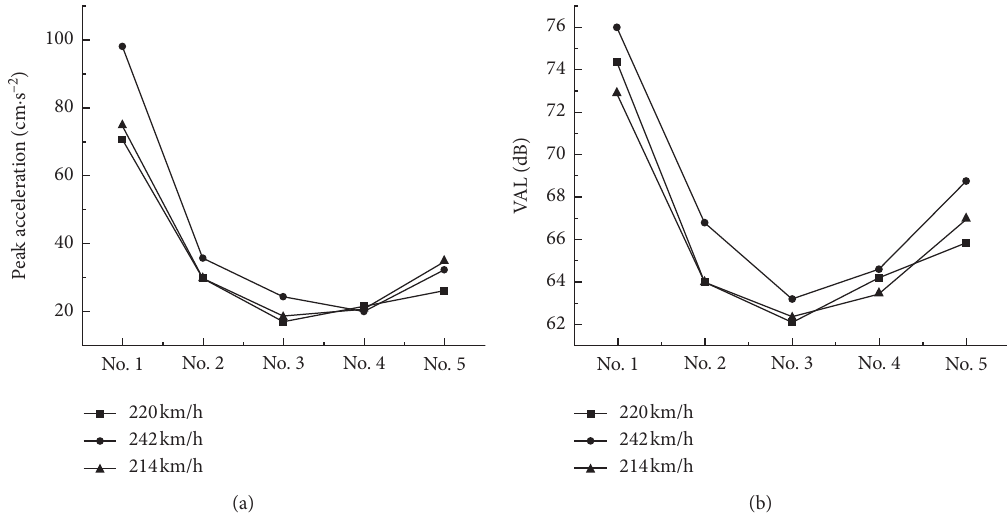
Figure 8: Peak acceleration in Y direction and VAL at five test points as a function of train speed. (a) Peak acceleration. (b) Vibration acceleration